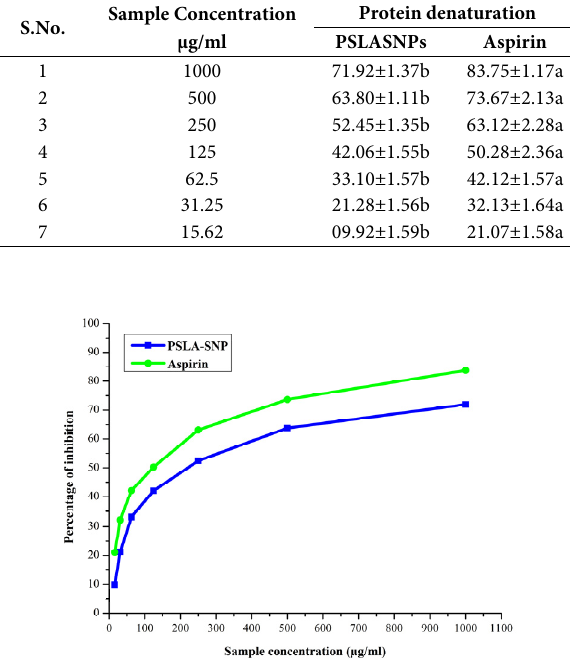
Fig. 1. Anti-inflammatory activity of PSLASNPs